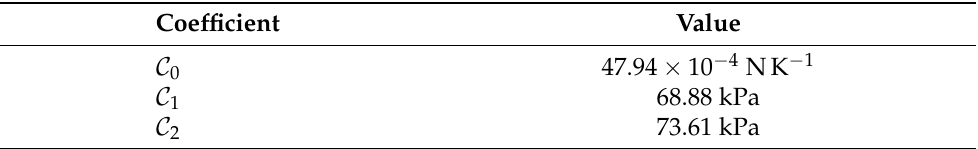
Table 1. Fit model coefficients for the Mooney-Rivlin equation in Equation (23) representing the force-stretch curve of the strip of TheraBand ® Latex, A 0 = 7 mm 2 , at room temperature T = 296 K. With goodness of fit: root mean squared error 0.18, R-Square 0.97. With C 0 root mean squared error 0.03, R-Square